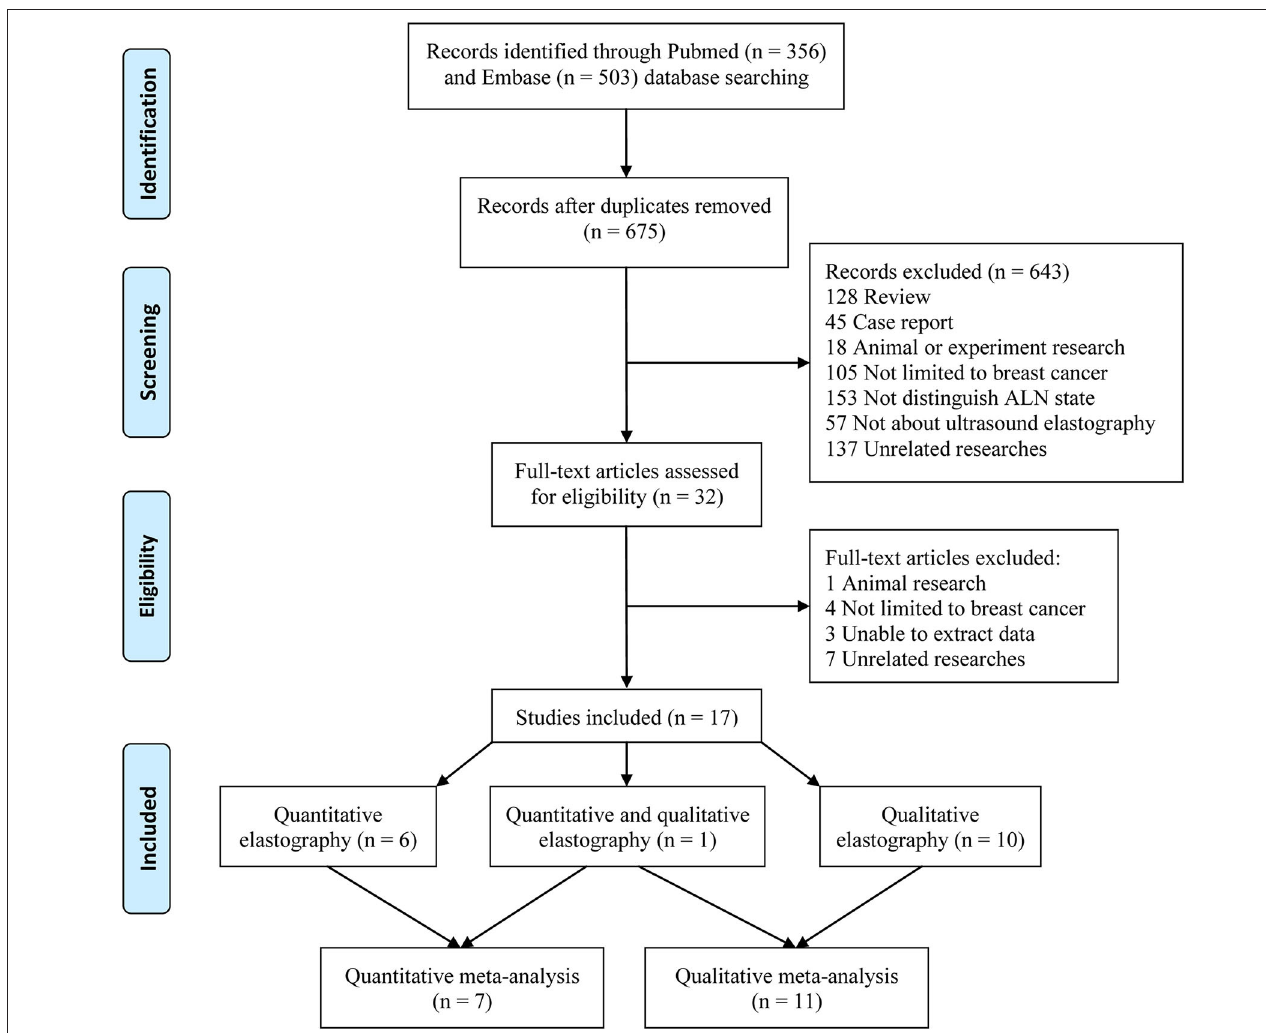
FIGURE 1 | Flowchart of eligible